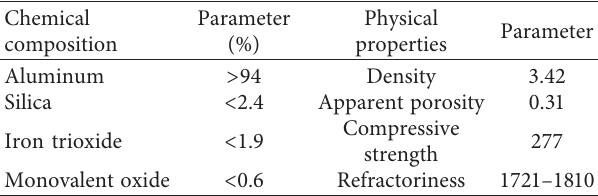
Figure 3: Preparation of alumina ceramics. Table 1: Composition and properties of alumina